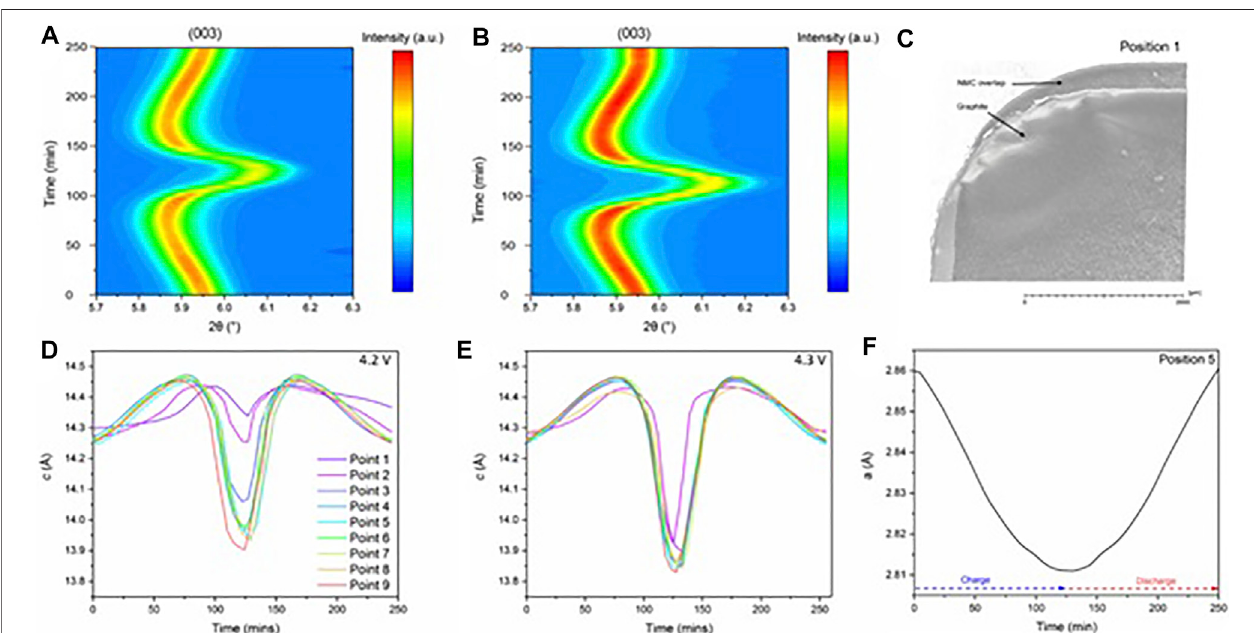
FIGURE 3 | Changes in the c-axis as a function of time for the nine points for (A) cutoff voltage of 4.2 V and (B) cutoff voltage of 4.3 V at a rate of 0.5 C. For cell 4.2 V,thediscrepanciesexistduetomisalignmentoftheelectrodes. (C) X-rayCTimageofthepristinecellshowinganoverlapofthecathodeonthecellcycledto4.2 Vat position 1. (D,E) The c-lattice parameter as a function of time during both charge and discharge, for the 4.2 and 4.3 V cells, respectively. Measurements at the same position in the cell are recorded at 5 min intervals (i.e., a full cycle of XRD measurements through the nine positions takes 5 min); therefore, not all positions are measured at exactly the same SoC. (F) The calculated a-lattice parameter as a function of charging and discharging for a rate of 0.5 C for the 4.3-V